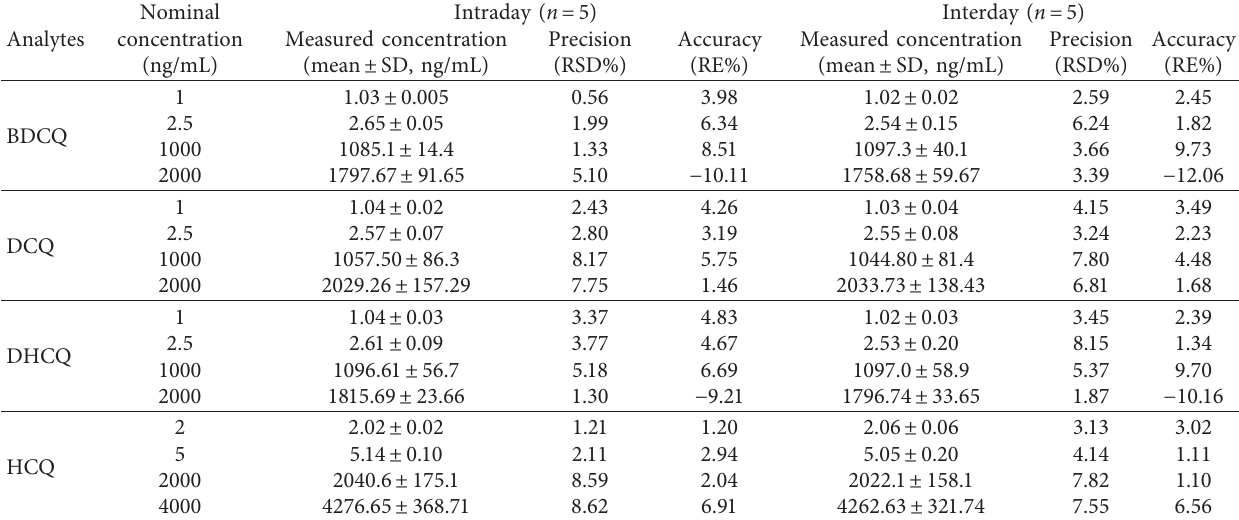
Table 4: Interday and intraday precision and accuracy of four analytes in rat blood ( n � 5).